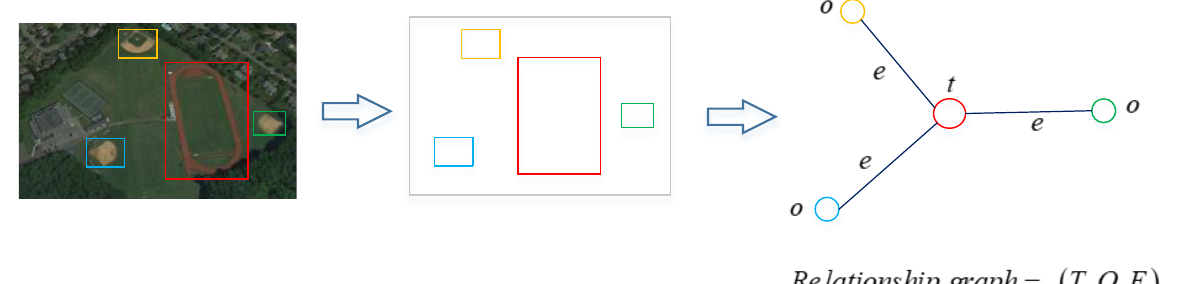
Figure 4. The graphical problem between target and objects.